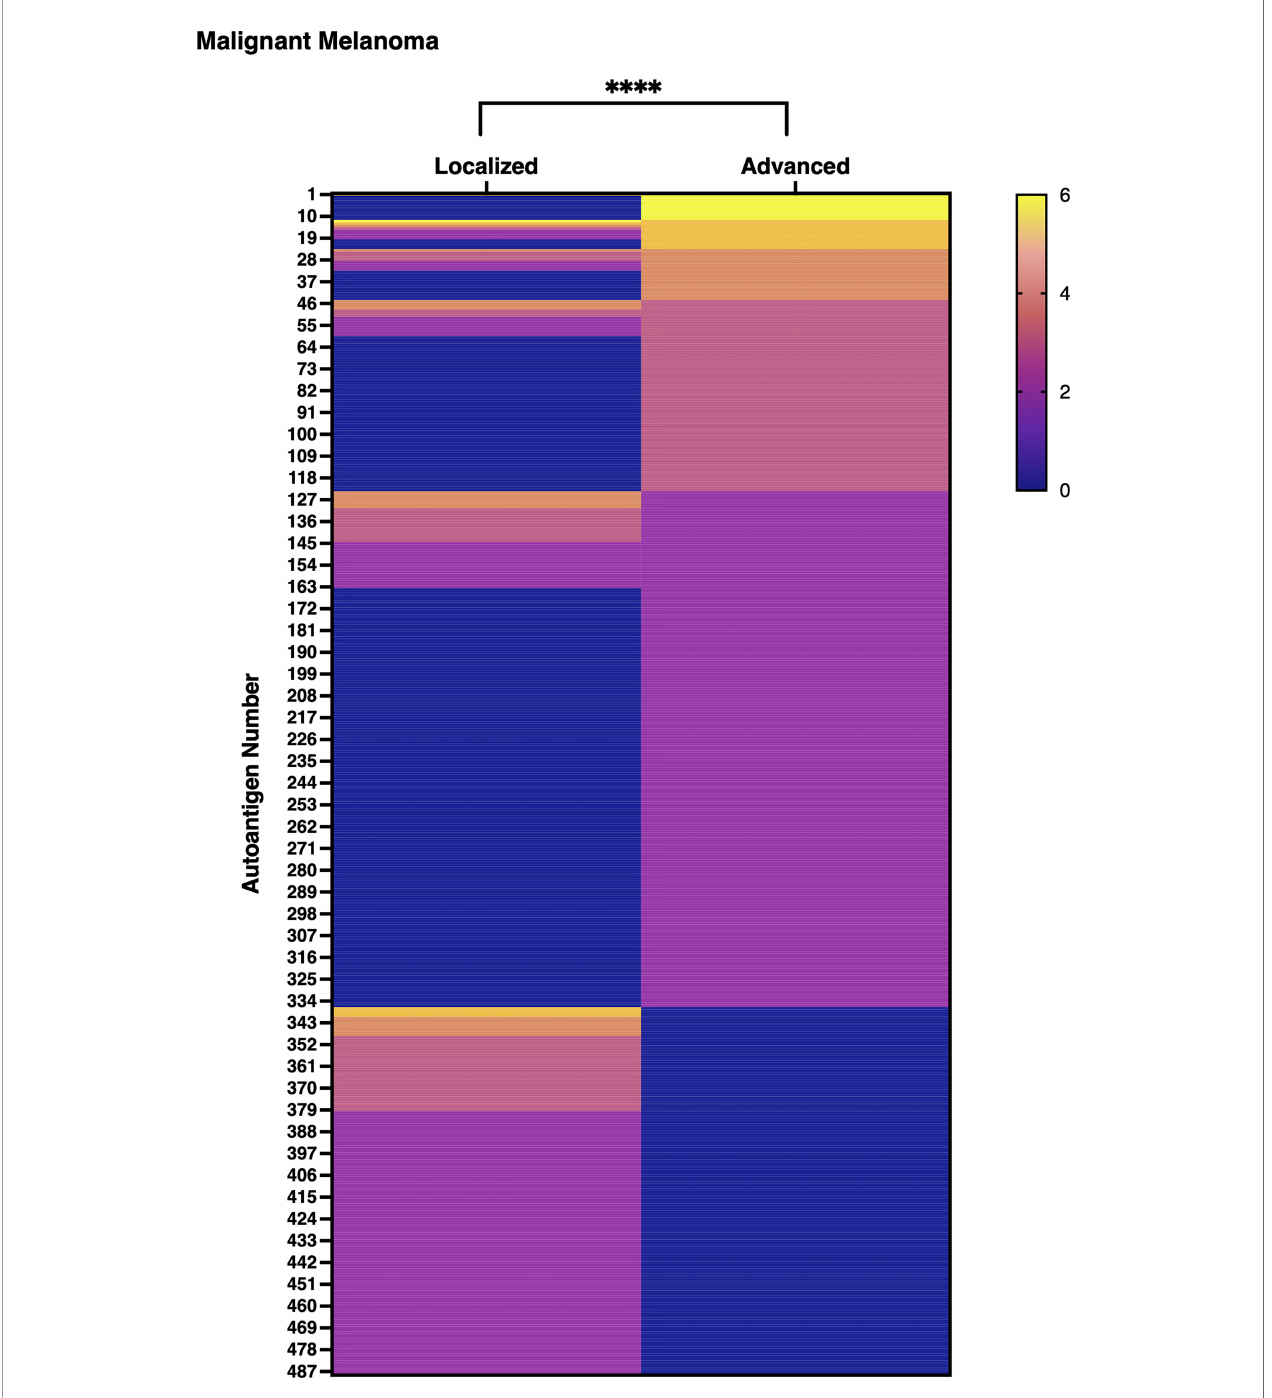
FIGURE 9 | Gross autoantibody product in localized and advanced malignant melanoma. The result of proteome-wide autoantibody detection from pooled serum of localized or advanced malignant melanoma (MM) patients is illustrated. Each row shows autoantibodies spotted on the focused wet protein array (WPA) and their signal strength on the proteome-wide WPA. Semi-quanti fi cation of signals on proteome-wide WPA was conducted as below: higher than positive control ’ s signal strength: 6, higher than 1/2 positive control ’ s signal strength but lower than positive control ’ s signal strength: 5, higher than 1/4 but lower than 1/2 of positive control ’ s signal strength: 4, higher than 1/8 but lower than 1/4 of positive control ’ s signal strength: 3, higher than 1/16 but lower than 1/8 of positive control ’ s signal strength: 2, higher than negative control ’ s signal strength but lower than 1/16 of positive control ’ s signal strength: 1. P value was calculated by Wilcoxon signed-rank test. **** P <